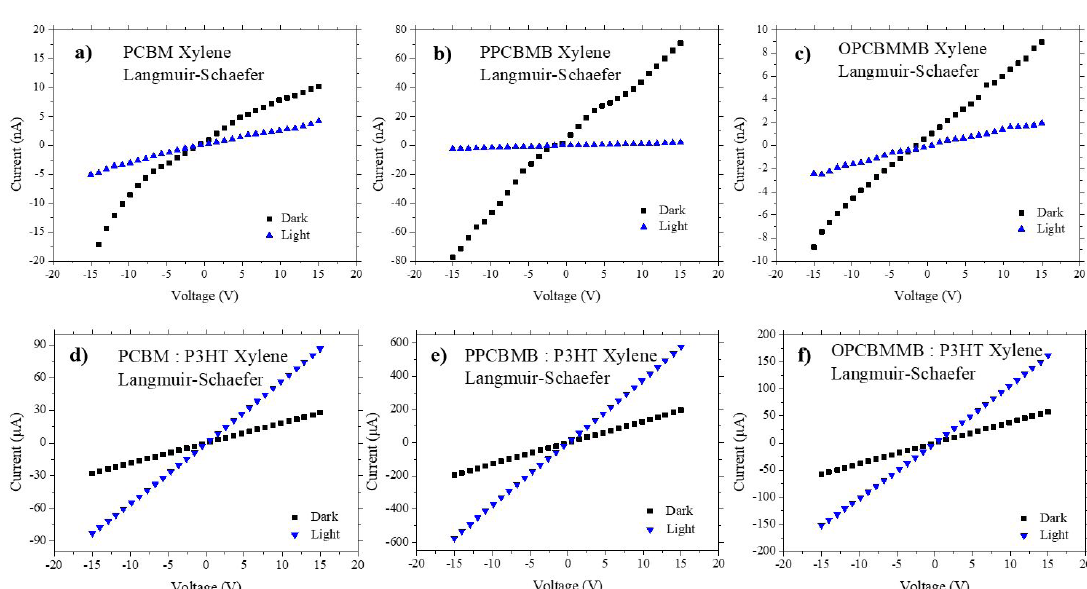
Figure 2. Chemical structure of P3HT.